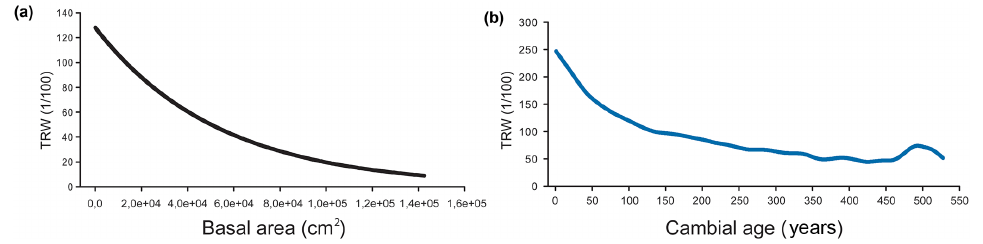
Figure 4. Panel (a) represents the model of the BasPois method, and (b) represents the regional curve of the RCS